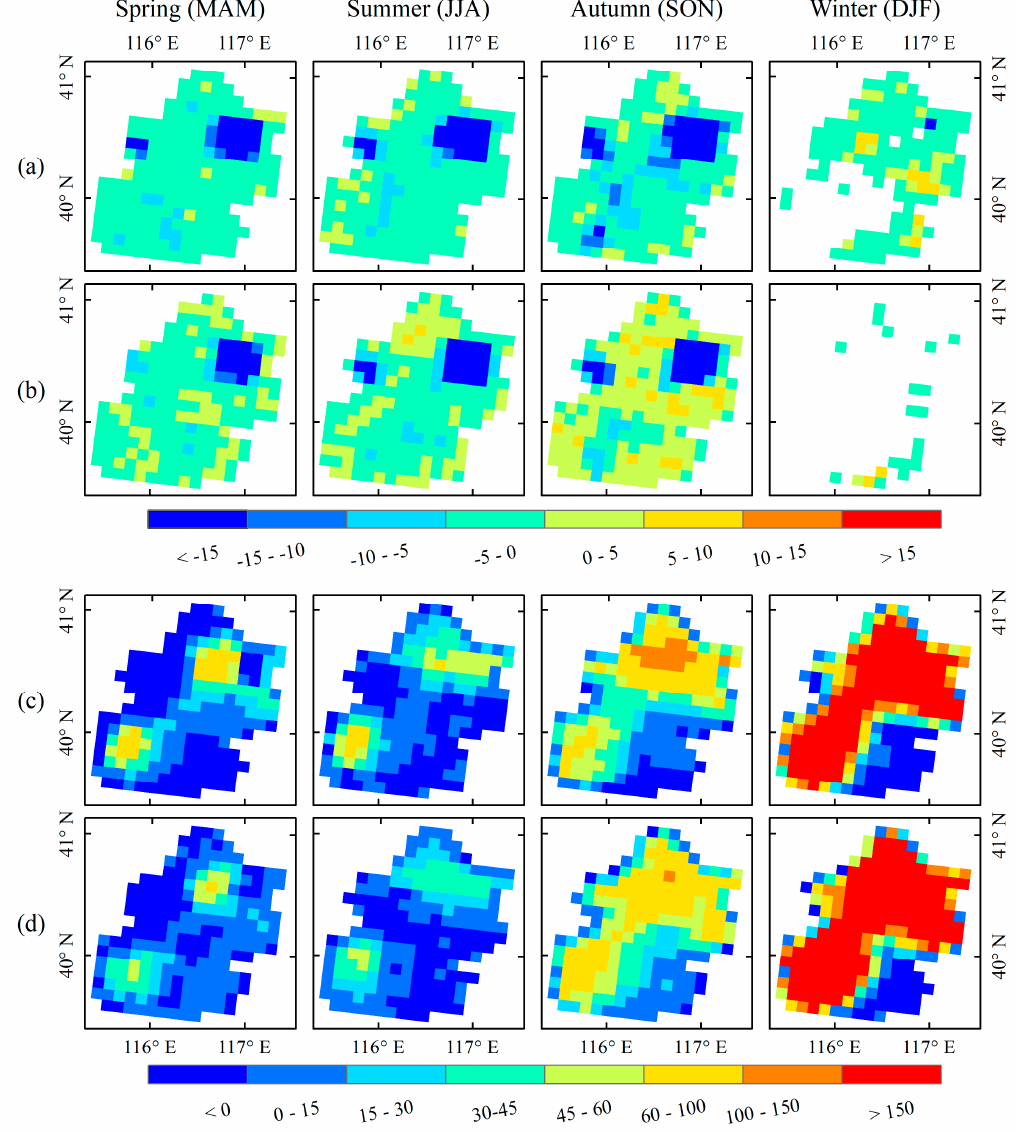
Figure 8. Seasonal differences in the number of days for the effective retrieval (NE) (C6.1_NE–C6_NE) of ( a ) MODIS-Terra (MOD04) DT, ( b ) MODIS-Aqua (MYD04) DT, ( c ) MOD04 DB, and ( d ) MYD04 DB AOD retrievals over Beijing. The MOD04 and MYD04 products were obtained from January 2001 to December 2016 and from July 2002 to December 2016, respectively.